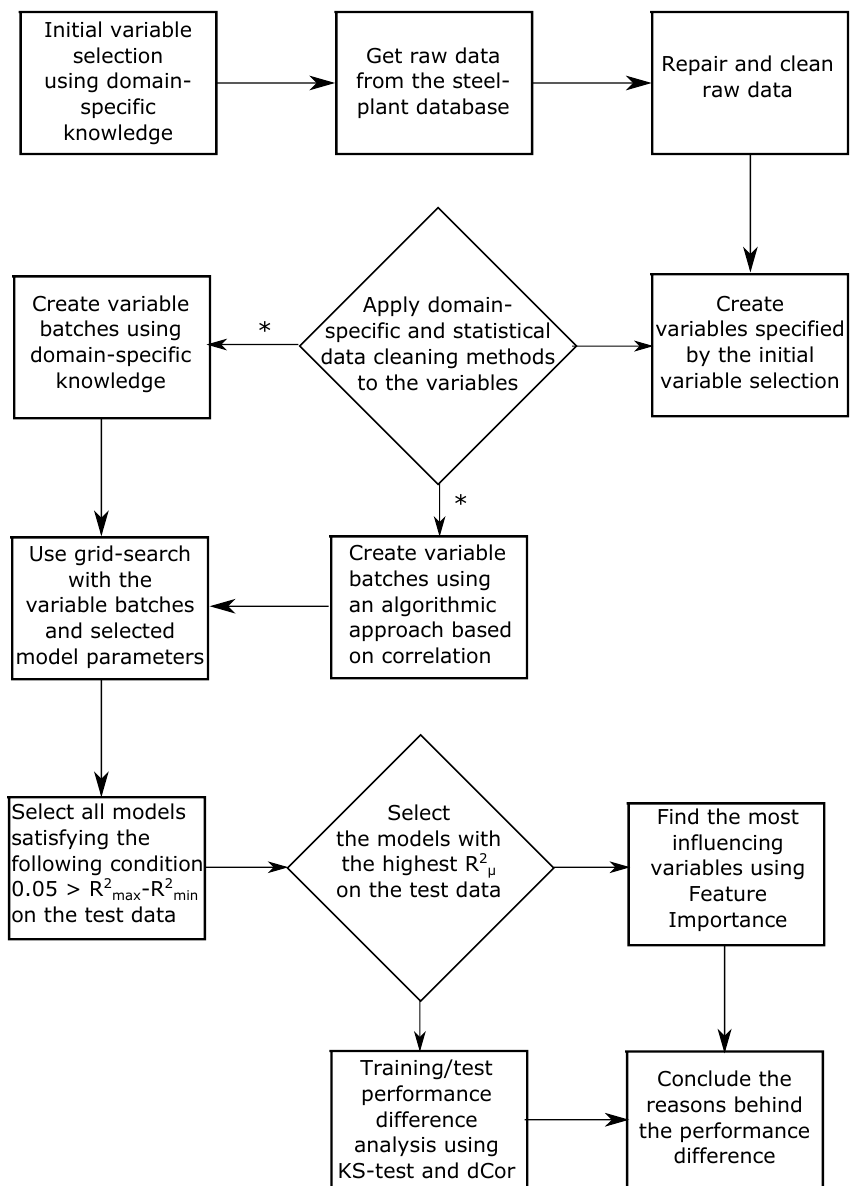
Figure 3. Flowchart explaining the data and statistical modeling pipeline. * The flowchart is split to emphasize the two different approaches used to select the variable batches for the